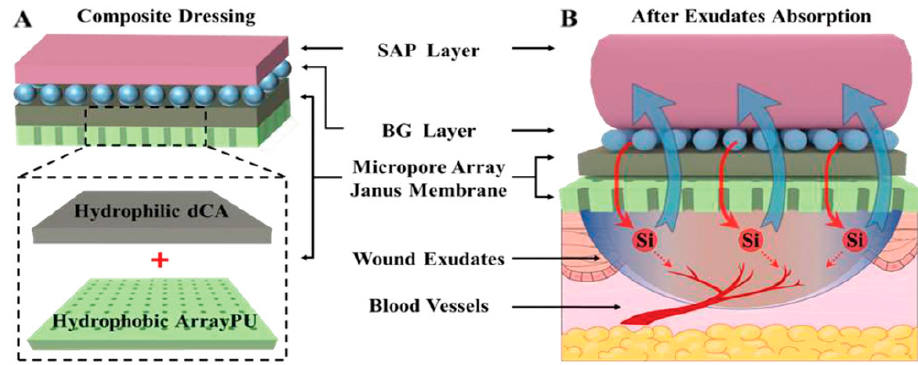
Figure 11. Illustrations of ( A ) composite dressing structure with modified Janus membrane and ( B ) absorption of massive wound exudates from the wound bed. SAP—sodium polyacrylate super- absorbent particles; BG—silicate bioglass; PU—polyurethane; dCA—deacetylated cellulose acetate layer. Reprinted with permission from [116], © Wiley, 2020.